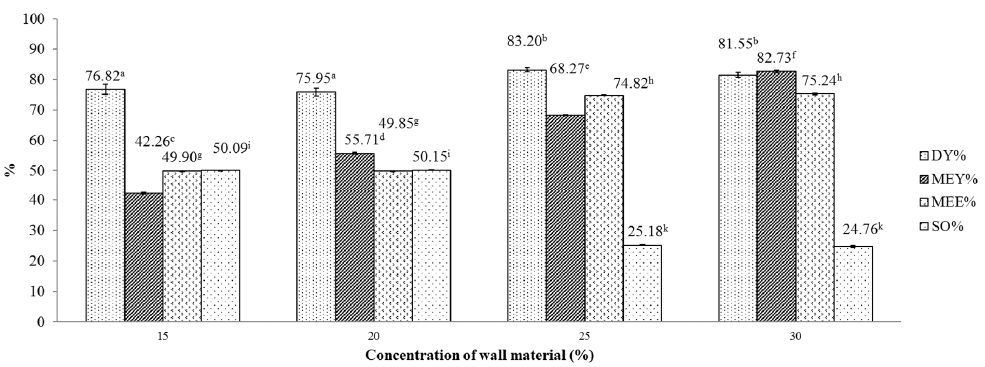
Figure 2. Effect of maltodextrin concentration on various indicators of the microencapsulation process. Figures with same letters indicate statistical indifference